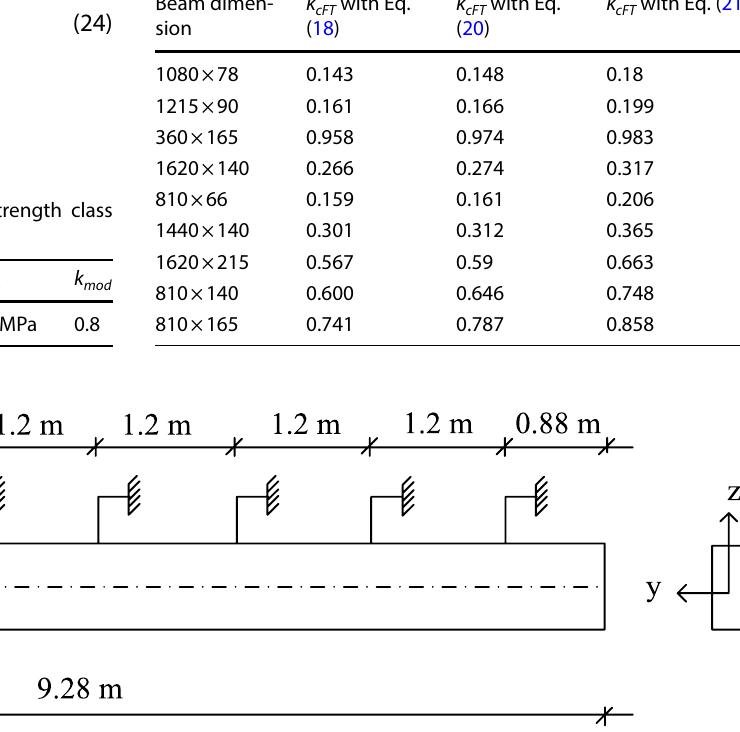
Table 2 Comparison between the different solutions to calculate k for glulam timber with strength class GL32c cFT Beam dimen-